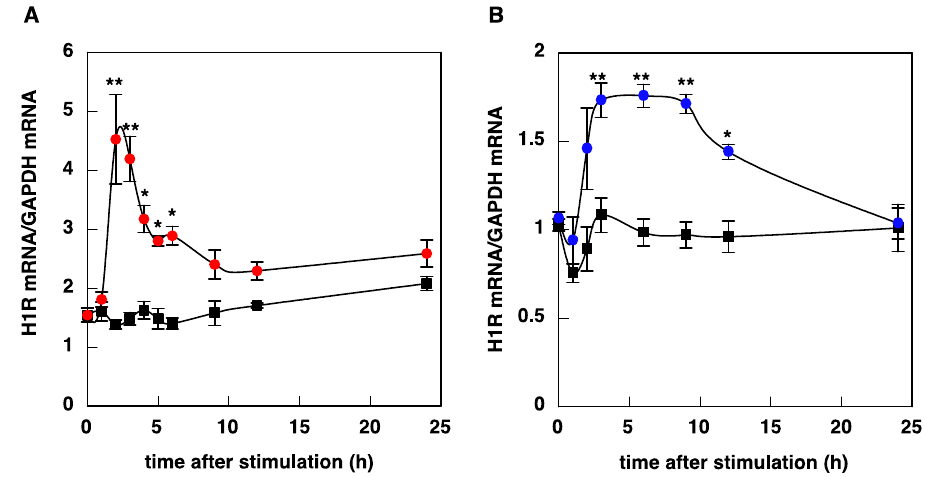
Figure 3. Time course of histamine-induced upregulation of H1R mRNA in U-373 MG cells ( A ) and HeLa cells ( B ). At given time intervals after stimulation with 100 µ M (U-373 MG cells) or 10 µ M (HeLa cells) histamine, total RNA was isolated, and H1R mRNA was determined by real-time quantitative RT-PCR. Closed circles, histamine; closed squares, control. Data are expressed as means ± SEM ( n = 8–12). * p < 0.05 vs. control; ** p < 0.01 vs. control. For statistical analysis, two-way ANOVA with Tukey–Kramer’s test was used.